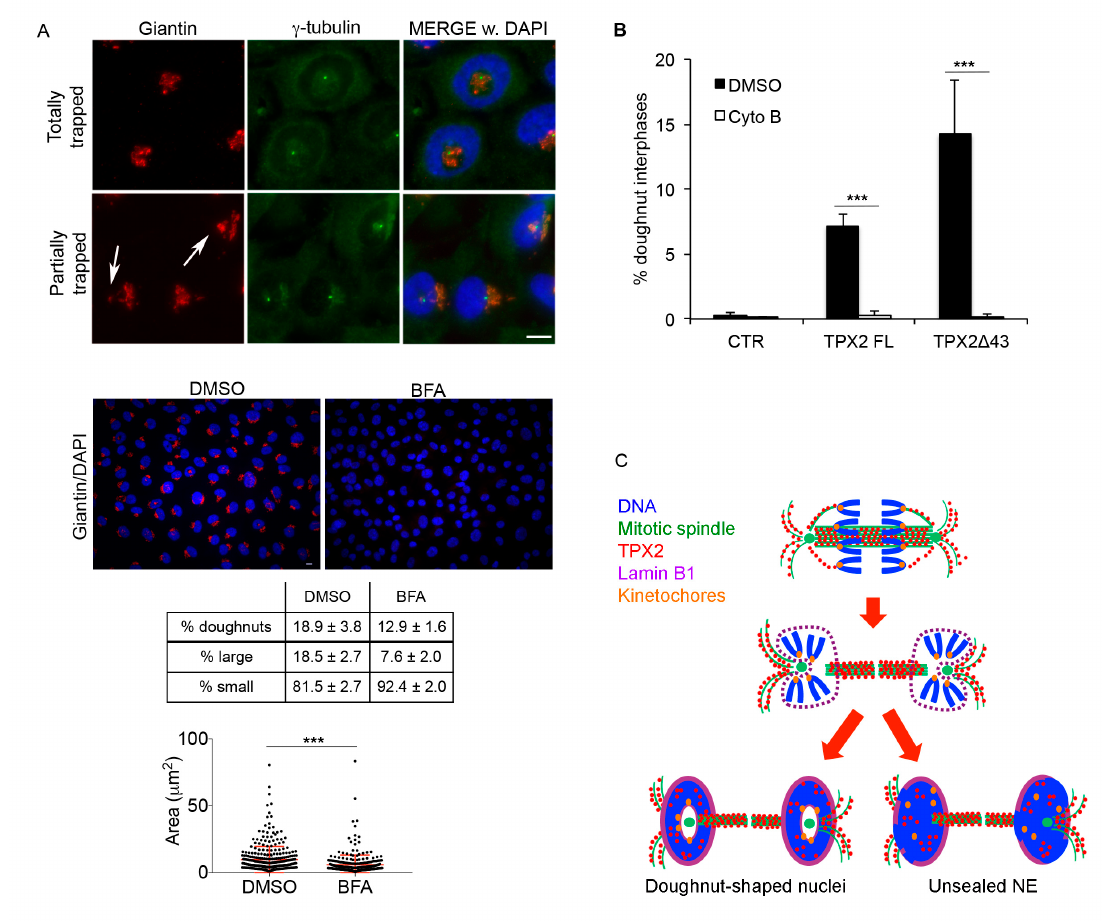
Figure 7. Golgi apparatus and cytoskeleton organisation contribute to doughnut-shaped nuclei generation. ( A ) Golgi organisation (giantin) in doughnut-shaped nuclei is shown in the upper IF panels. White arrows indicate trapped Golgi vesicles. Exemplifying images of control (DMSO) or Brefeldin A (BFA)-treated TPX2 ∆ 43 overexpressing cultures are shown (red: giantin; blue: DAPI). The table indicates the percentage of doughnut-shaped nuclei in TPX2 ∆ 43 cells after treatment with Brefeldin A (BFA; 1500 cells per condition were counted from three independent experiments); lower rows indicate the distribution of doughnut-shaped nuclei (at least 600 counted doughnuts per condition from 3–4 independent experiments) depending on the size of the hole. s.d. are indicated; p < 0.0001, chi-square (and Fisher’s exact) test for all BFA-treated vs. DMSO control cultures. Examples of “large holes” are in the upper IF panels, while “small” ones are exemplified in lower IF panels; “hole” measurements are shown in the graph below (300 measured doughnuts per condition, from three independent experiments; *** p < 0.0001; Mann–Whitney test). Scale bars: 10 µ m. ( B ) Histograms indicate the percentage of doughnut-shaped nuclei in the indicated cell lines after cyto B treatment. A total of 1500 cells per condition were counted from three independent experiments; s.d. are shown; *** p < 0.0001, chi-square (and Fisher’s exact) test. ( C ) A model for the formation of doughnut-shaped nuclei and / or unsealed envelopes, from mitoses overexpressing TPX2, is depicted. The colour code is indicated. See text for details.